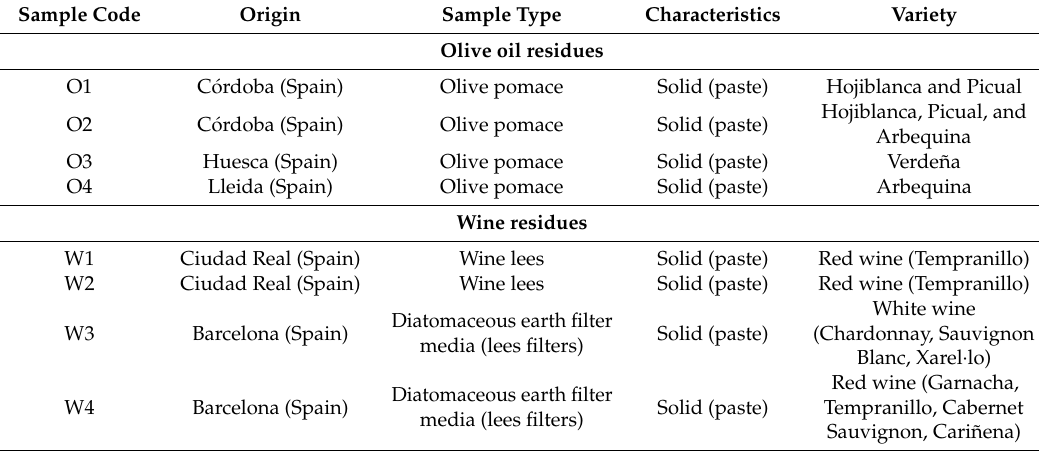
Table 1. Olive oil and winery residue